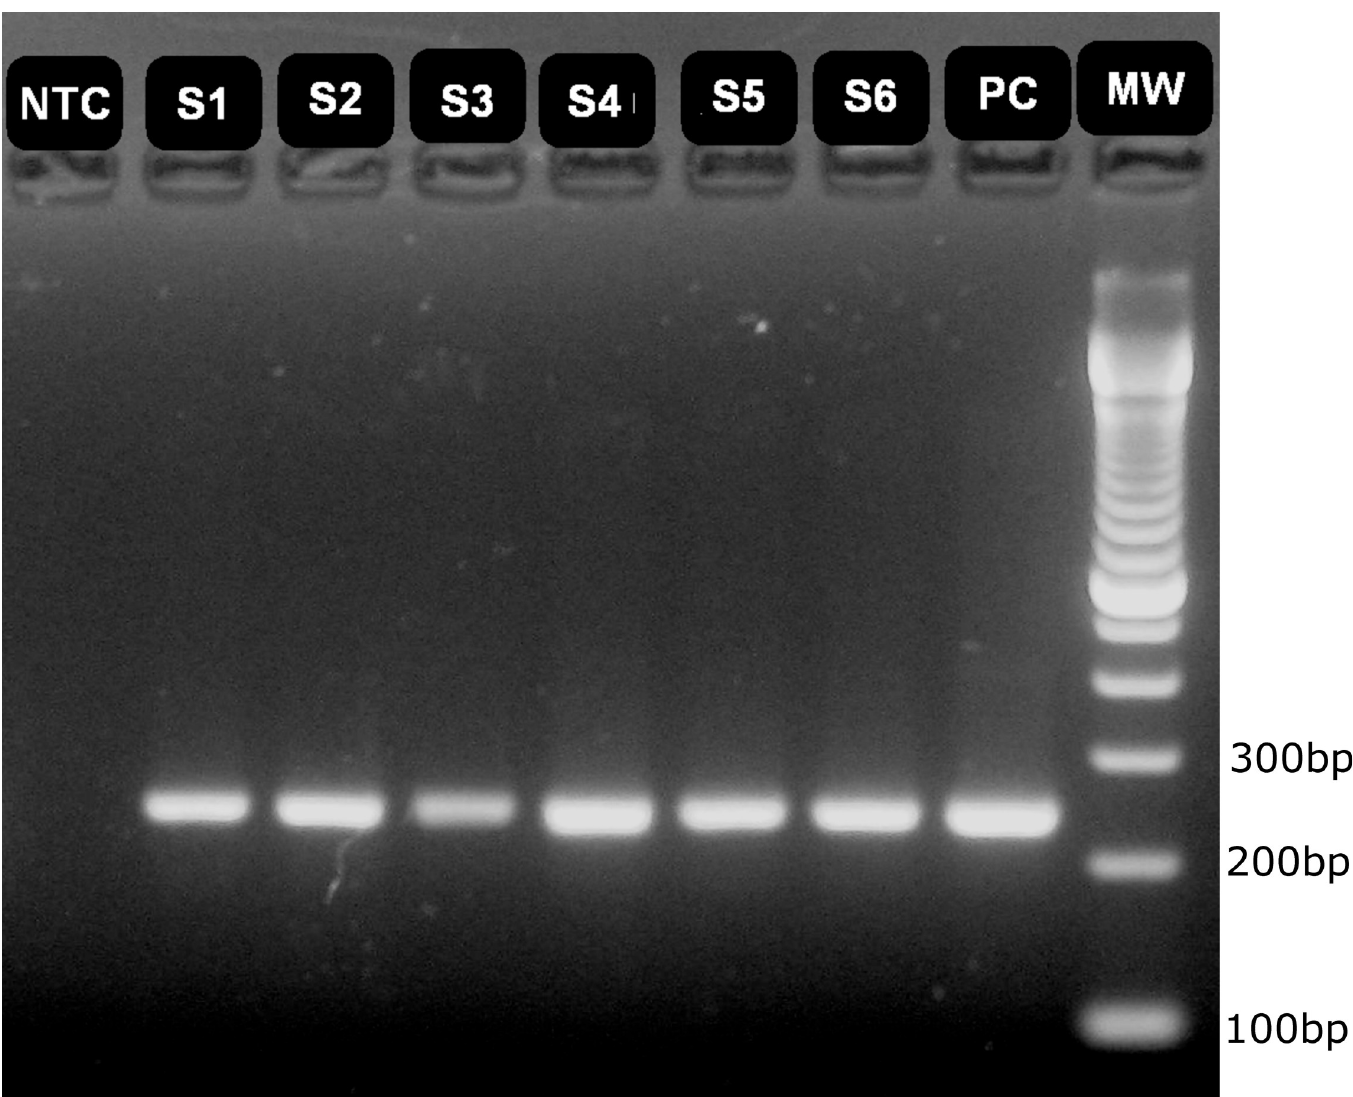
Fig 2. Agarose gel electrophoresis of hantavirus Semi-nested RT-PCR amplification products from clinical samples positive for IgM-ELISA. Agarose gel (1.5%) stained with SYBR safe dye were run for 50 min at 120V in TBE buffer. Each lane was loaded with 5 μ L of sample diluted in BlueJuice ™ Gel Loading Buffer (Invitrogen). NTC: No template Control, S1-6: sample 1–6, PC: Positive Control, MW: Molecular weight (100bp DNA Ladder—Invitrogen).